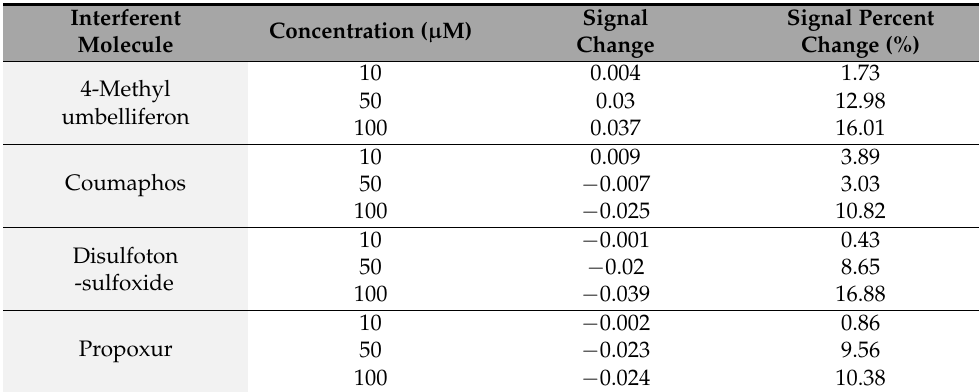
Table 2. Effect of interferents on DPV current response of anodic peak of 10 µ M CFN at CFN- MIP